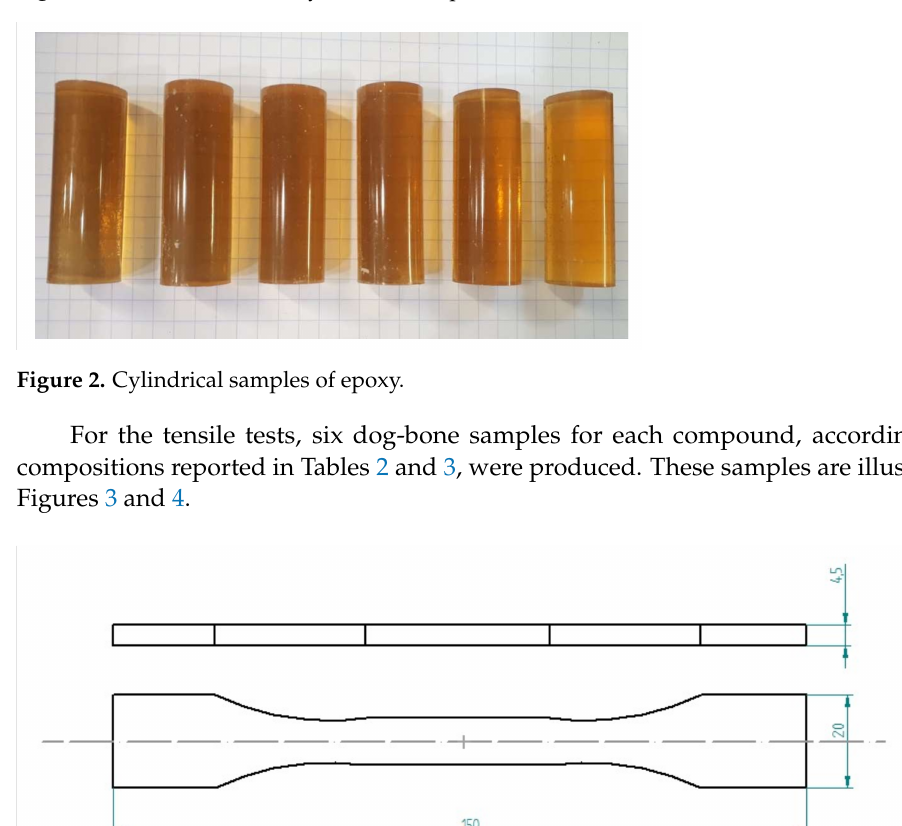
Figure 1. Dimensions of the cylindrical samples.